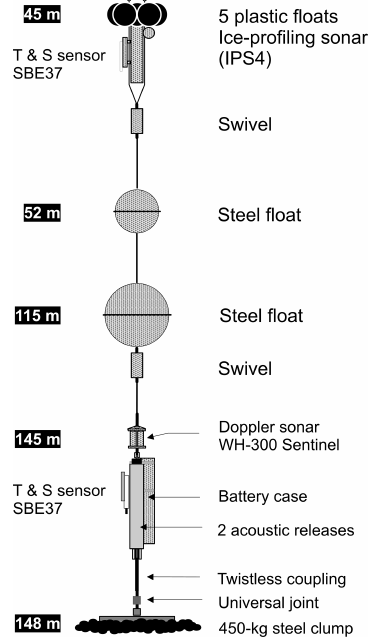
Figure 3. Mooring used to support sonar in the Penny Strait. The twistless coupling enables measurement of ice-drift